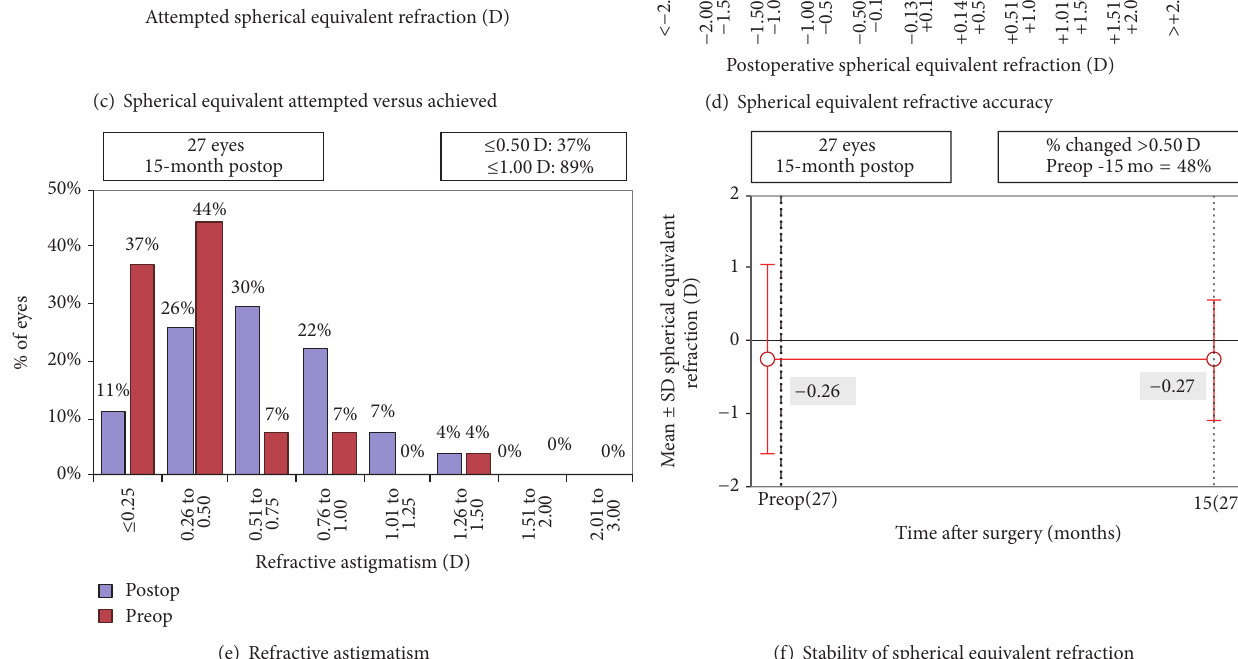
Figure 1: Refractive outcomes, efficacy, and safety (CDVA = corrected distance visual acuity; D = dioptre; SER = spherical equivalent refraction; Postop = postoperative; Preop = preoperative; SD = standard deviation; UDVA = uncorrected distance visual acuity). Haigis-L formula was used in the illustration of spherical equivalent refraction